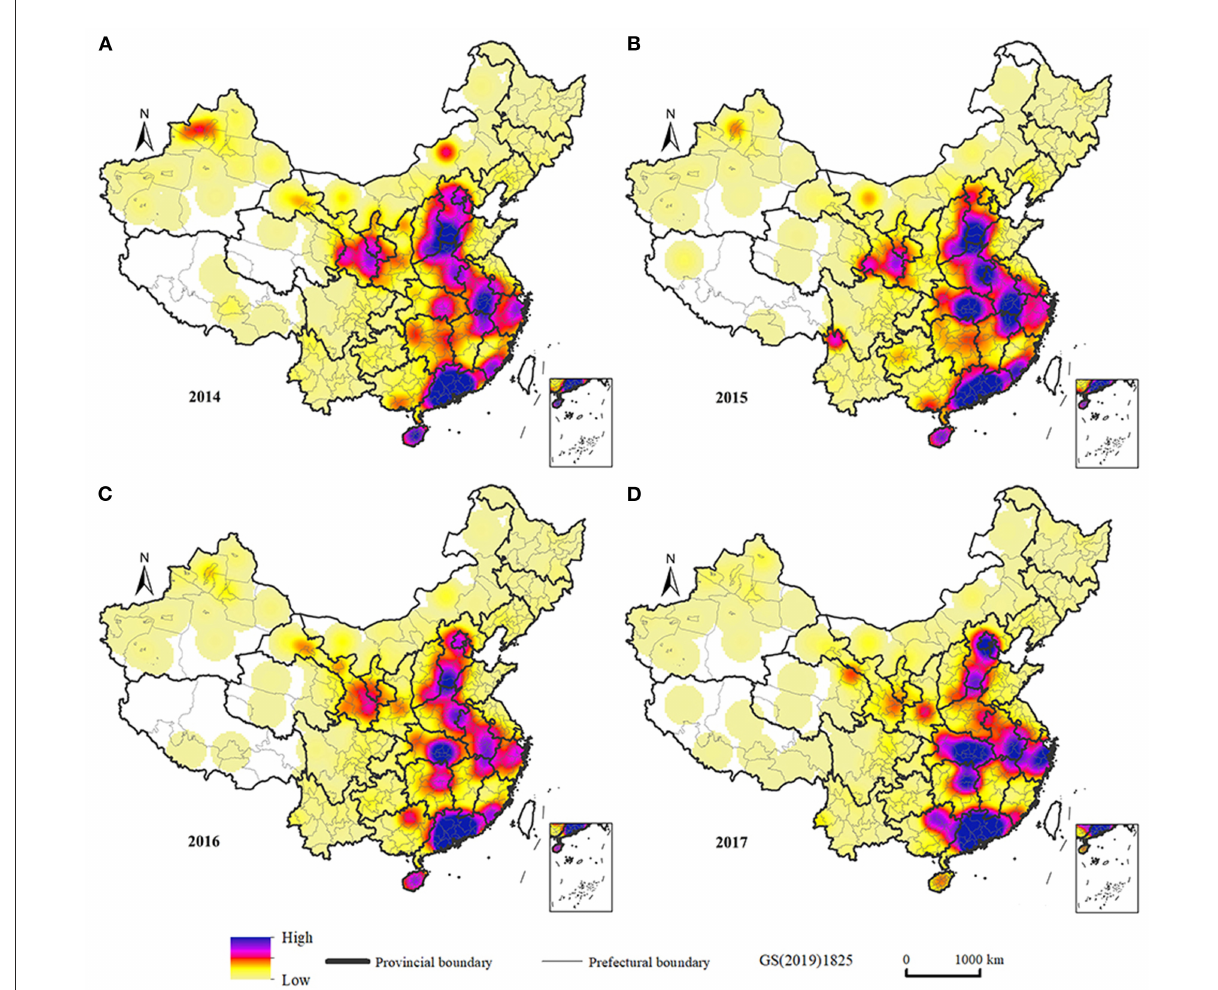
FIGURE3 Kernel density estimation of influenza incidence in China. (A) Influenza incidence in 2014. (B) Influenza incidence in 2015. (C) Influenza incidence in 2016. (D) Influenza incidence in